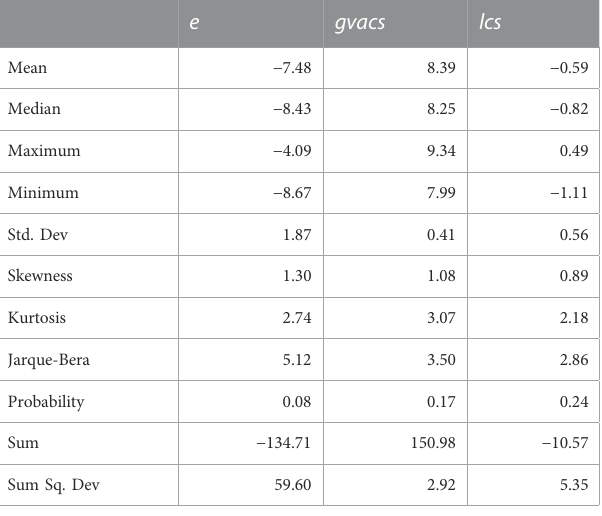
Panel A: Natural logarithm levels of variables Panel B: Growth rates of the variables